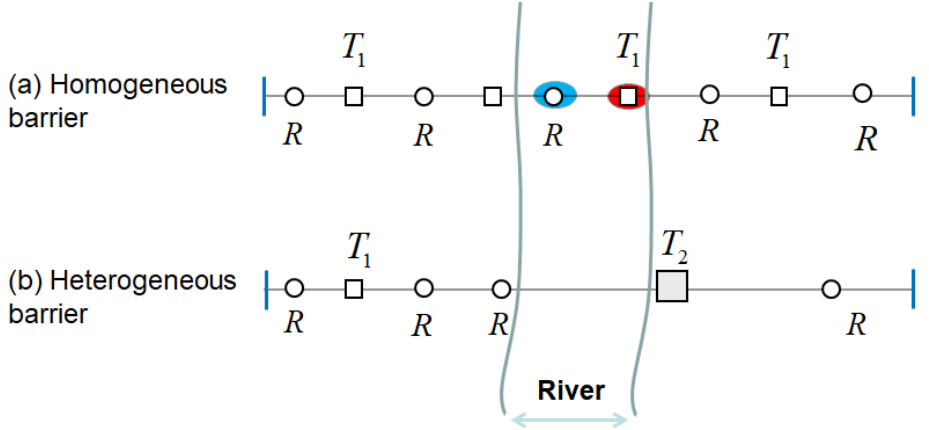
Figure 1. The homogeneous and heterogeneous BR barrier coverage scenario across the same river. ( a ) Homogeneous BR barrier deployment using three T 1 transmitters and five receivers. ( b ) Heterogeneous BR barrier deployment using T 1 , T 2 transmitters and four receivers.